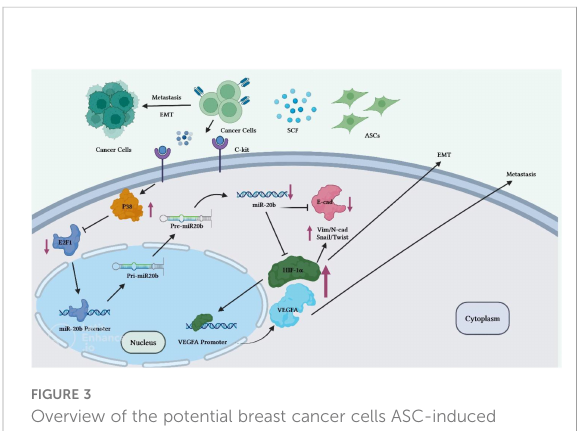
FIGURE 3 Overview of the potential breast cancer cells ASC-induced metastatic pathways. Through the regulation of miR-20b biogenesis, c-Kit-positive ASCs release high level of SCF to target BC cells. The MAPKp38/E2F1 pathway mediates the SCF- dependent decrease in miR-20b, which enhances activity of HIF-1/VEGFA and promotes EMT and metastasis of BC cells. Activation of the HIF-1 a /VEGFA results in the upregulation of the N-cadherin, vimentin, and Twist expressions and decreased expression levels of E-cadherin. Therefore, through miR-20b suppression, ASCs induces metastasis of BC cells in animal models. ASC, Adipose tissue-derived mesenchymal stem cells, BC, Breast cancer